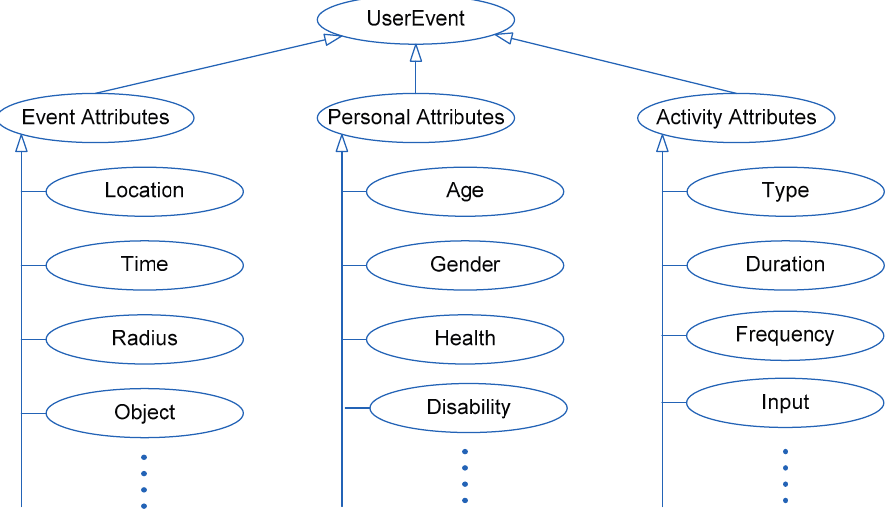
Figure 5. Ontology model for representation of common AmI